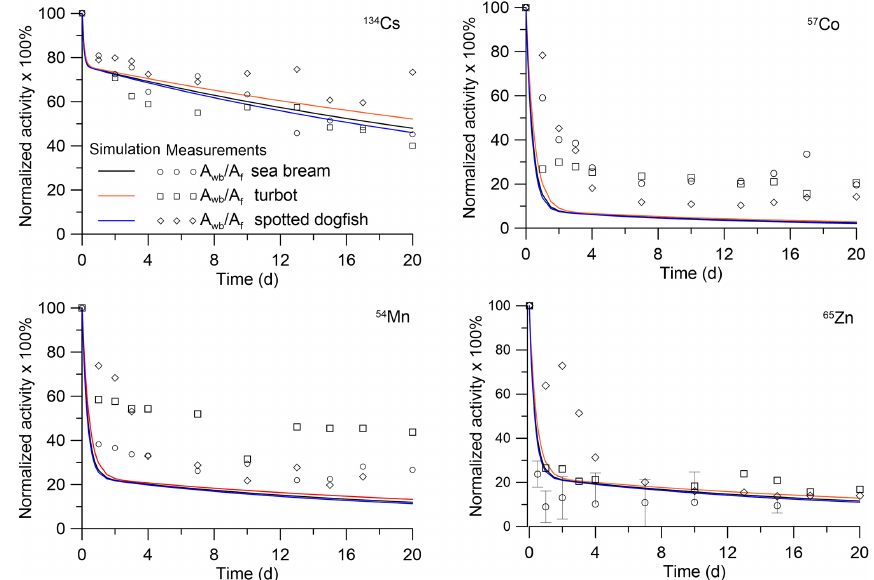
Figure 4. Retention of radionuclides in whole bodies of predator fish: sea bream ( Sparus auratus ), turbot ( Psetta maxima ) and spotted dogfish ( Scyliorhinus canicula ). The simulations are compared with whole-body measurements by Mathews et al.